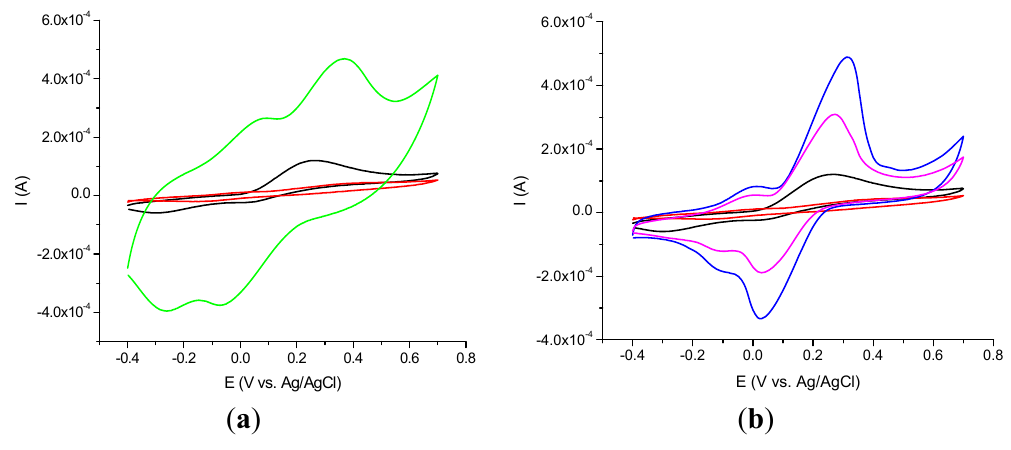
Figure 2. The electrochemical behavior of 10–4 M acetaminophen in PBS (pH 7.4; 0.1 M) at: ( a ) SWCNT/PEI (green) and ( b ) MWCNT (type 1)/PEI (blue); MWCNT (type 3)/ PEI (magenta); compared with GCE simple (black) and GCE modified with PEI